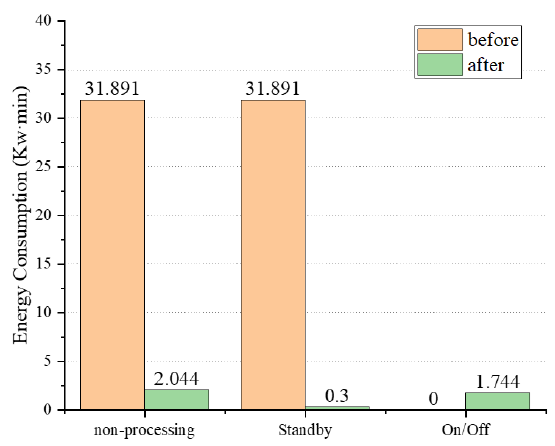
Figure 27. Influence of the machine tool on/off strategy on non-processing energy consumption.